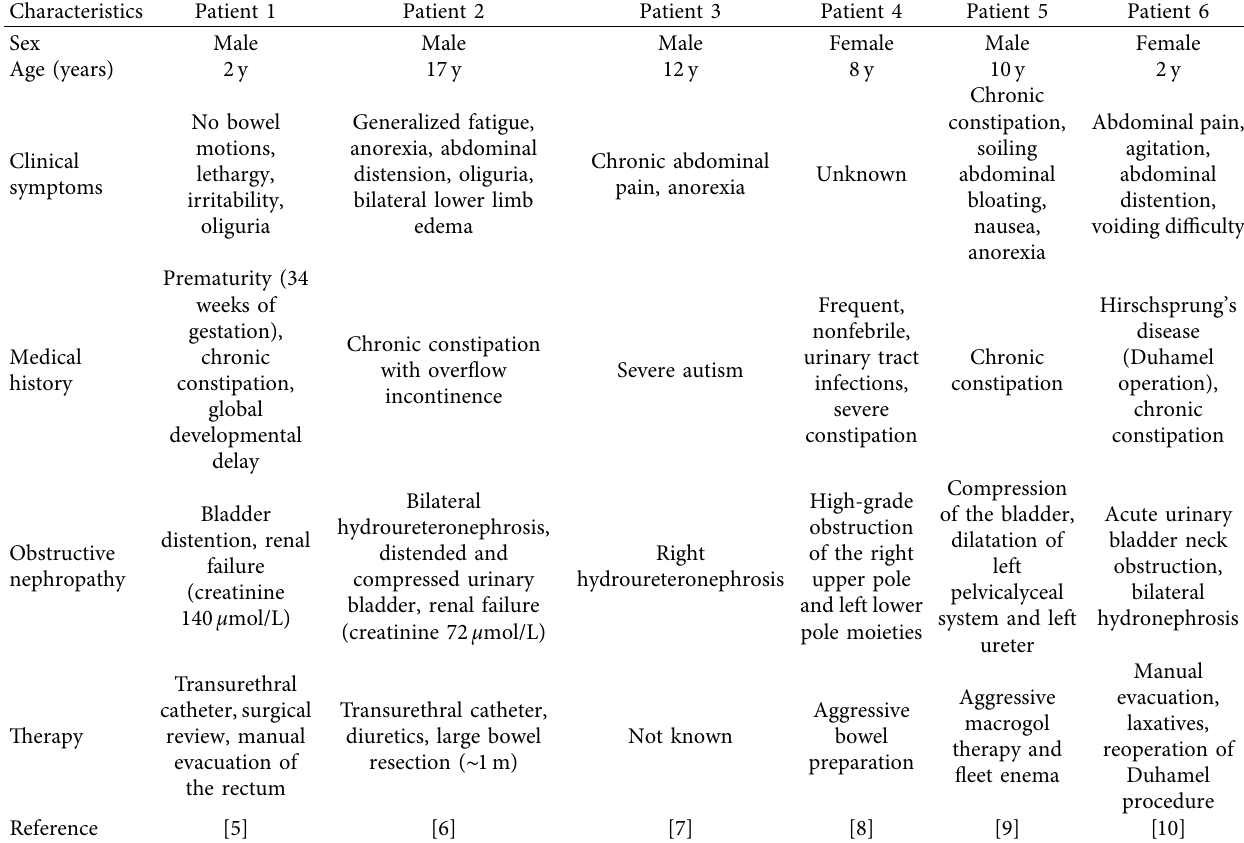
Table 1: Constipation presenting with